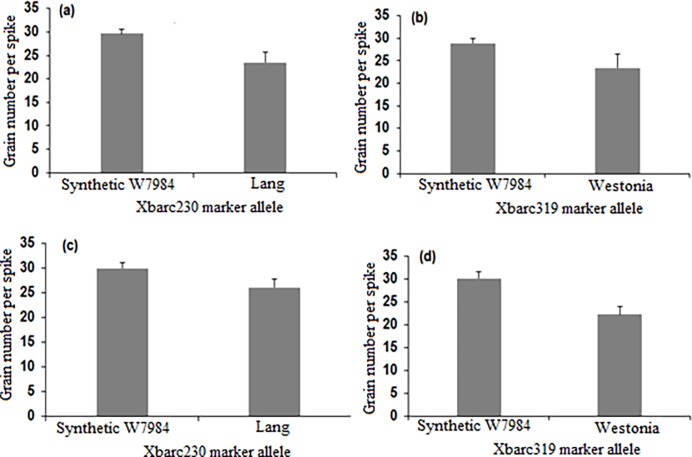
Validation of SSR markers Xbarc230 and Xbarc319 associated with the identified QTL for grain number per spike under water stress during meiosis.(a) and (c) indicate F2:4 lines homozygous for Xbarc230 marker alleles from Synthetic W7984 and Lang parental lines, (b) and (d) indicate F2:4 lines homozygous for Xbarc319 marker alleles from Synthetic W7984 and Westonia parental lines. Values shown are means and error bars are standard errors of the means. Two-sample t-test revealed that under water stress during meiosis, the mean difference in grain number per spike between the allele combination groups in different F2:4 validation populations was statistically significant (P ≤ 0.05) for both Xbarc230 and Xbarc319 marker alleles.